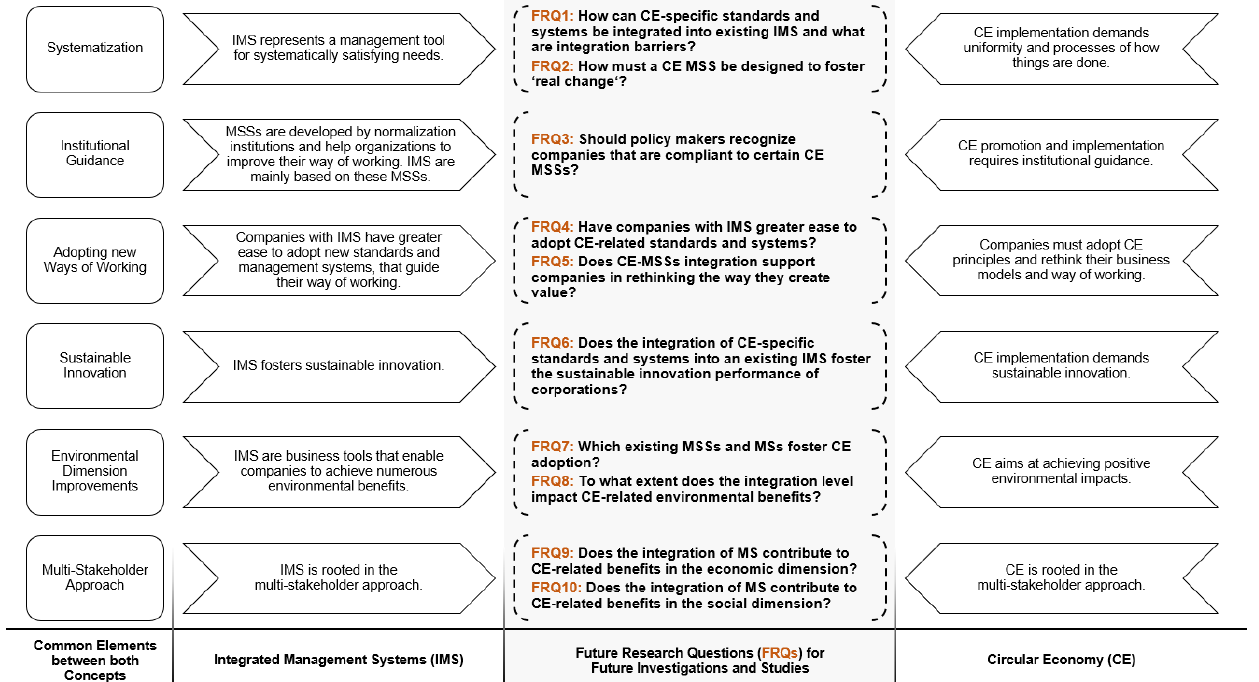
Figure 3. Proposed Future Research Agenda clustered by Common Elements between IMS and